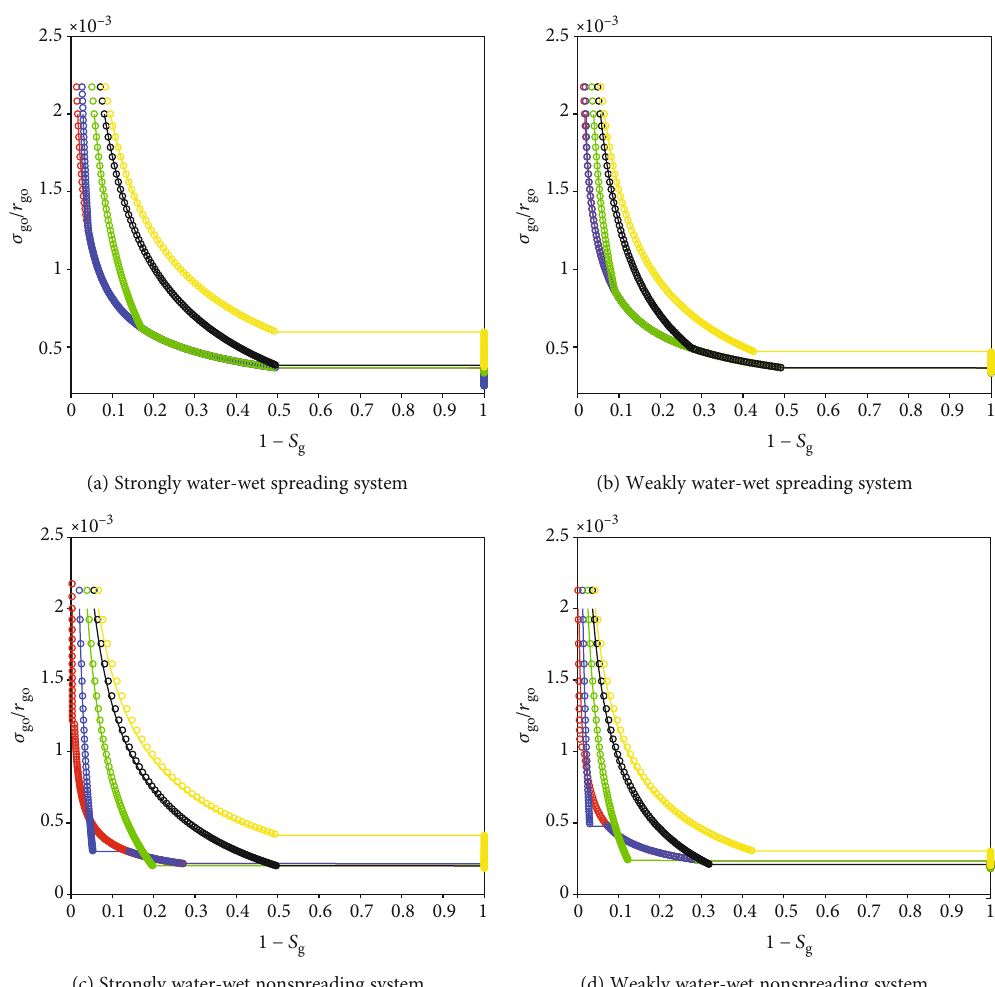
Figure 7: Gas-oil capillary pressure as a function of total liquid saturation in a tube with star-shaped cross-section for gas invasion originating from di ff erent constant oil-water interface radii (given in pixel lengths) r curve: analytical solution; open circle: semianalytical